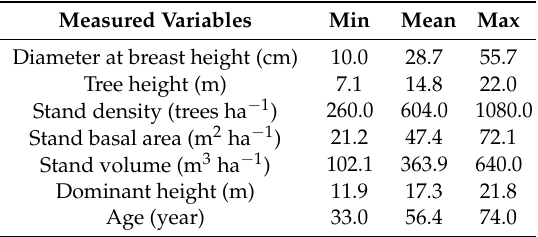
Table 1. Summary of field plot